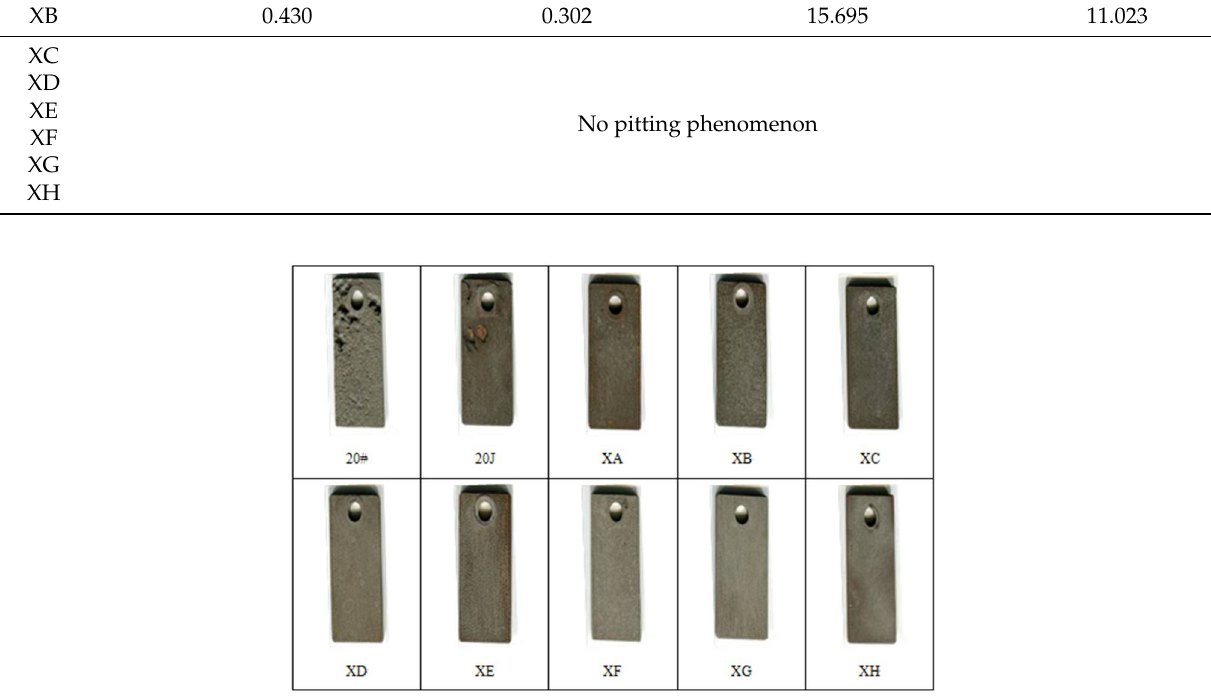
Figure 11. Morphology of coupons after the experiment. Table 14. Pitting rate in the case of CO 2 partial pressure of 1 MPa and 80 °C.